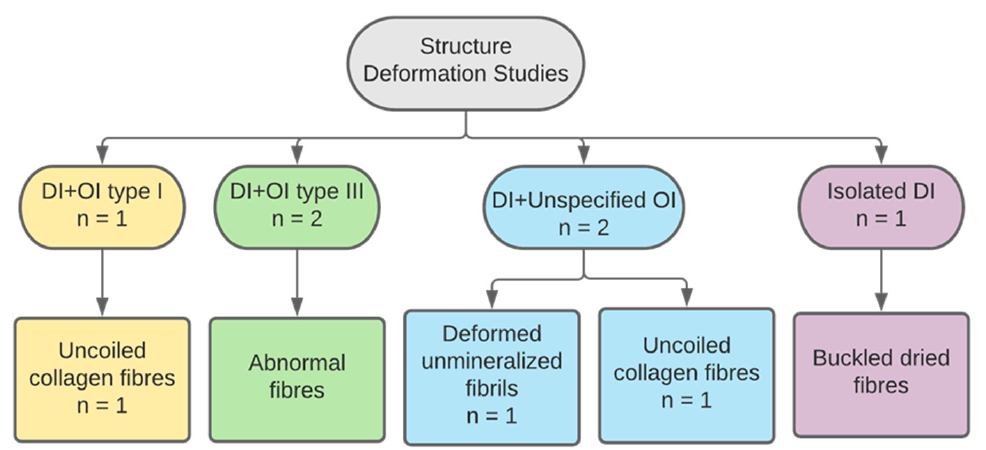
Figure 10. Categorization of studies reporting on collagen structural deformation by DI and OI types.